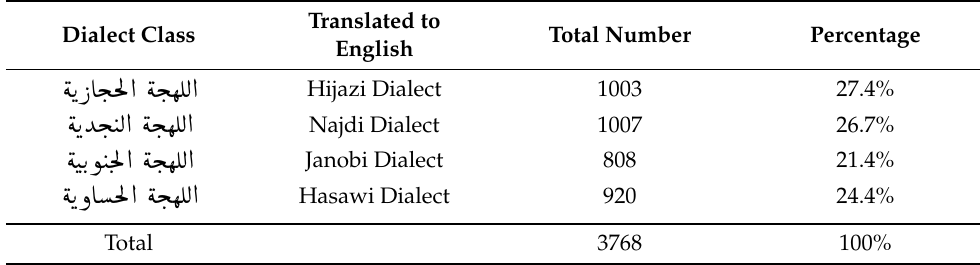
Table 1. Statistics for the collected